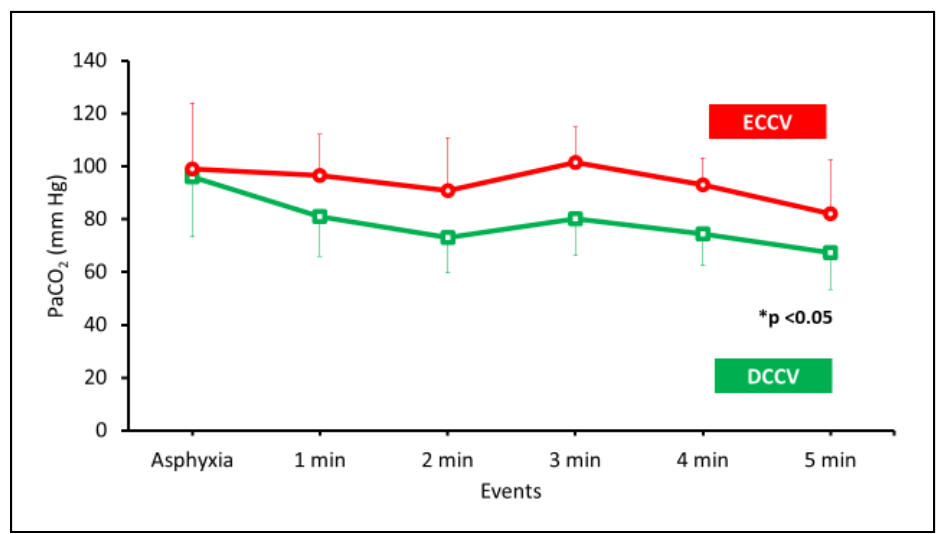
Figure 5. The arterial carbon dioxide (PaCO 2 in mmHg) is shown on the y -axis and the events on the x -axis. The PaCO 2 was significantly lower in DCCV compared to ECCV. (* p < 0.05 by ANOVA).